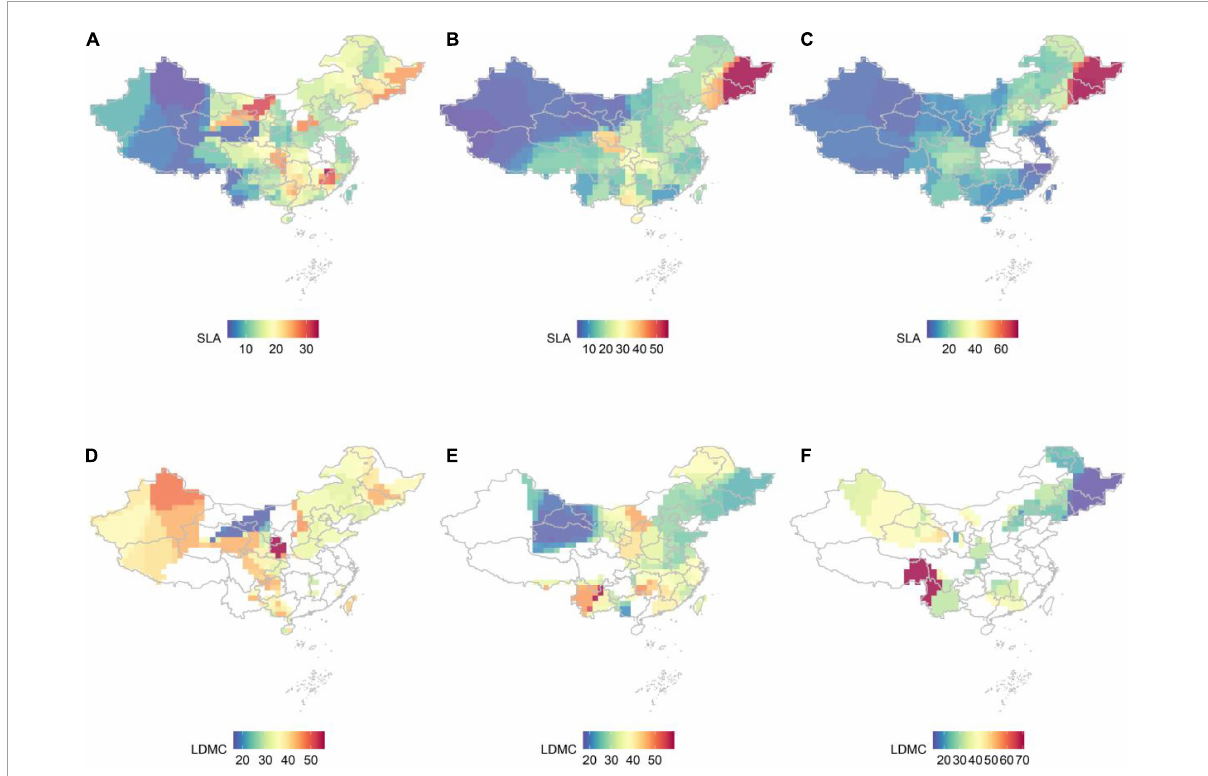
FIGURE1 The distribution pattern of SLA and LDMC at different life forms in China, with a spatial resolution of 1 × 1 km, was studied by kernel density estimation. (A) SLA for trees; (B) SLA for shrubs; (C) SLA for herbs; (D) LDMC for trees; (E) LDMC for shrubs; (F) LDMC for herbs.